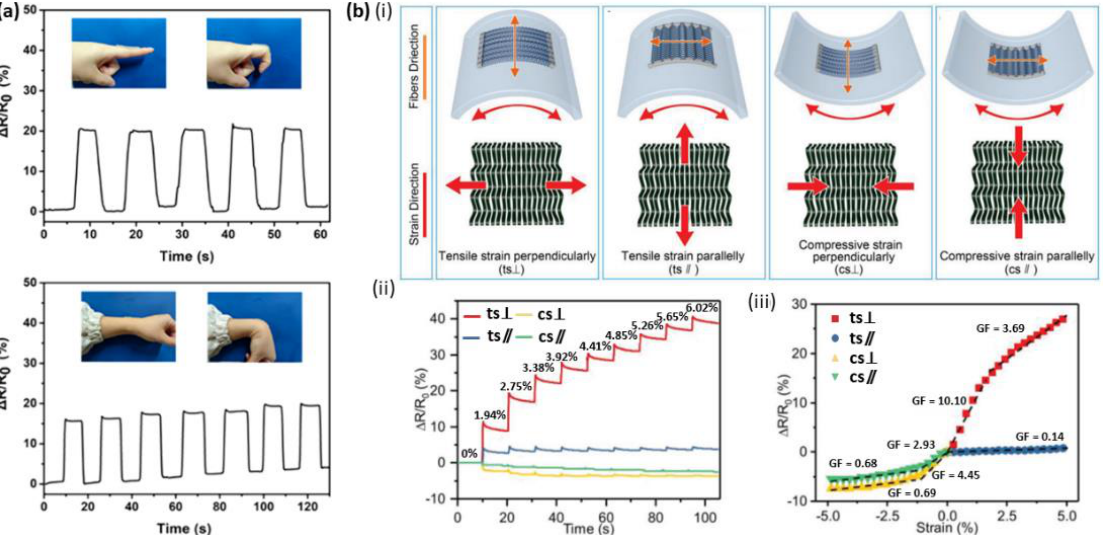
Figure 12. ( a ) Change in the HPMC-g-AN/AM-ZnCl 2 hydrogel sensor relative resistance upon finger (top) and wrist (bottom) bend/stretching, respectively [175]. ( b ) Sketch of the four different bending modes of the flexible cellulose-based carbonized crepe paper (CCP) strain sensor (i): tensile strain perpendicularly (ts ⊥ ), tensile strain parallelly (ts ∥ ), compressive strain perpendicularly (cs ⊥ ) and compressive strain parallelly (cs ∥ ) as well as the relative resistance change under various bending strains (ii) and the relative resistance change as a function of strain (iii) [176]. Copyrights: all the images have been adapted and reproduced with permission from: ( a ) © 2020, American Chemical Society; ( b ) © 2018 WILEY-VCH Verlag GmbH & Co. KGaA, Weinheim.